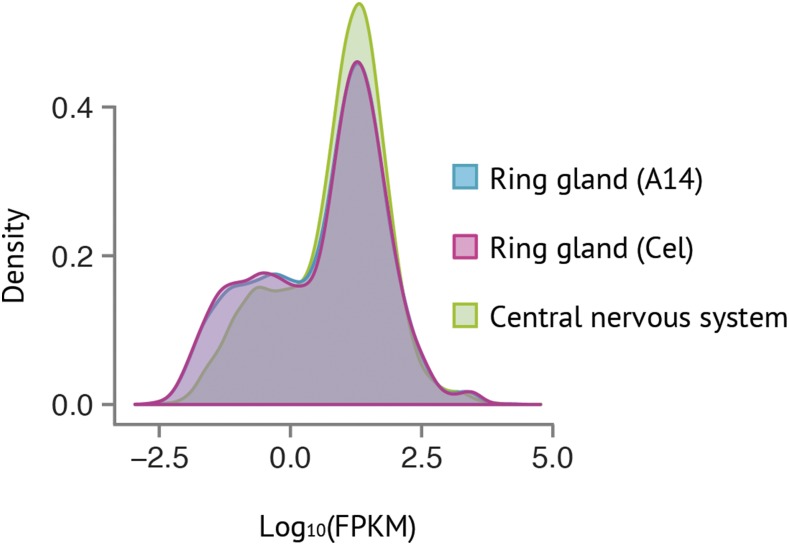
Distribution of FPKM values for all genes in the Armenia14 RG (blue), the Celera RG (pink), and the Oregon-R central nervous system (green). The distribution is similar for all samples. RG samples have more genes that are very lowly expressed (FPKM < 1), while the CNS has more genes that are lowly (1 < FPKM < 10) to moderately (10 < FPKM < 50) expressed. The image was generated using CummeRbund (Trapnell et al. 2012).